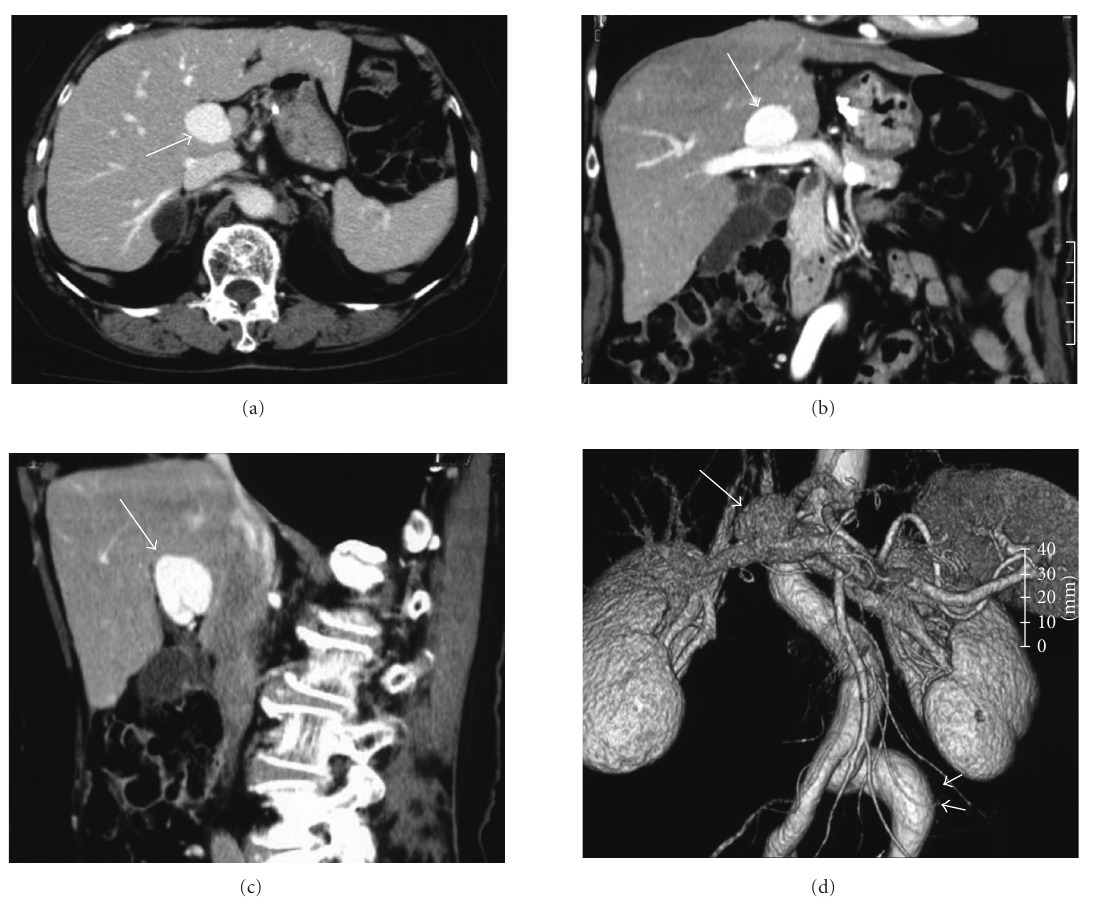
Figure 2: 3D-CT (a) horizontal view, (b) coronary view, and (c): sagittal view and CT angiography (d) demonstrated that the saccular aneurysm at the hepatic hilum was 30mm in diameter and was enhanced equal to that of the portal vein (white arrow). CT angiography demonstrated left common iliac artery aneurysm (white arrow